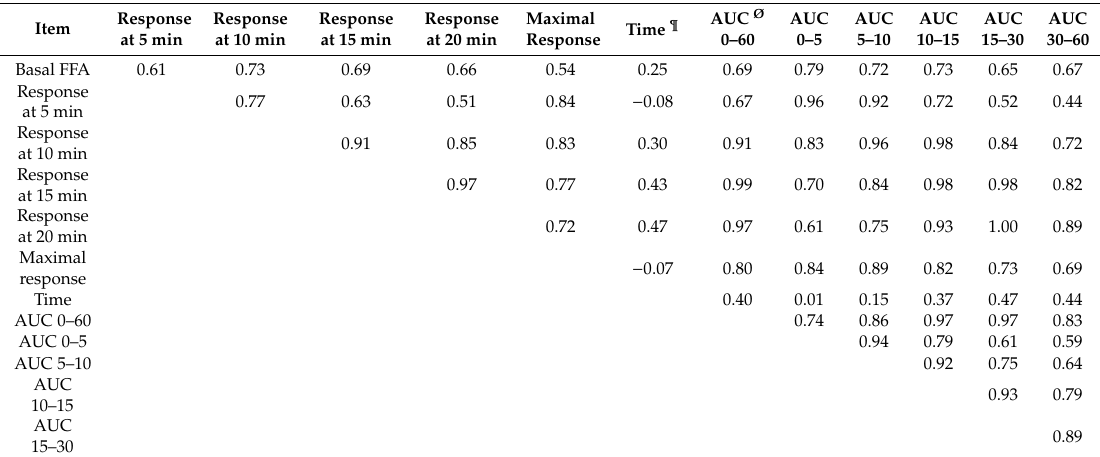
Table 6. Correlation coefficients* between basal plasma FFA and plasma FFA responses to the isoproterenol challenge in overfed, underfed or control Merinos d’Arles ewes ( n = 36).